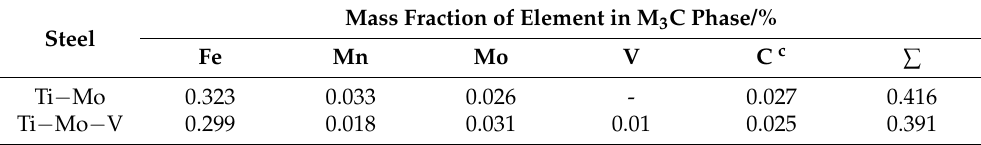
Table 4. Quantitative analysis of M 3 C precipitates of Ti − Mo and Ti − Mo − V steel.